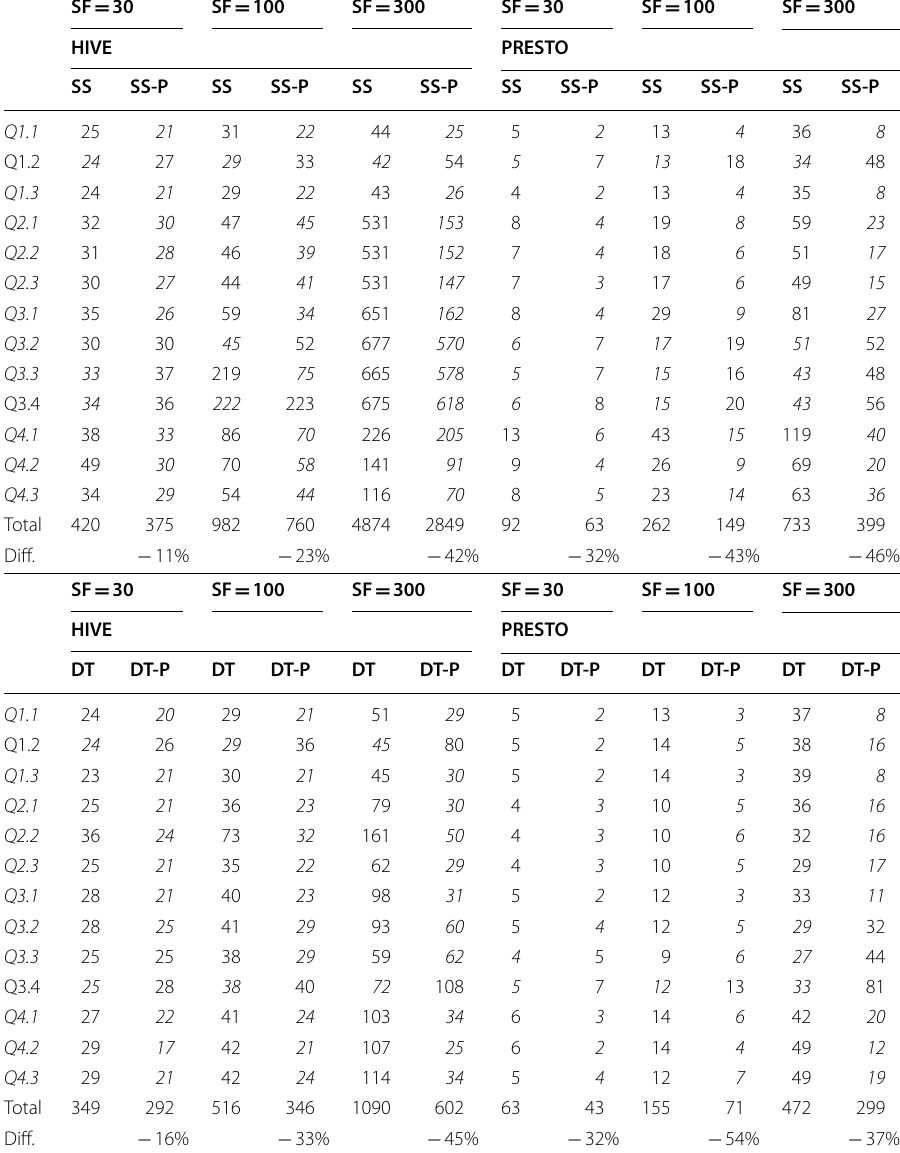
Table 1 SSB execution times (in seconds): partitioning by “Od_Year” and “S_Region” (star schema (SS), star schema with partitions (SS-P), denormalized table (DT), denormalized table with partitions